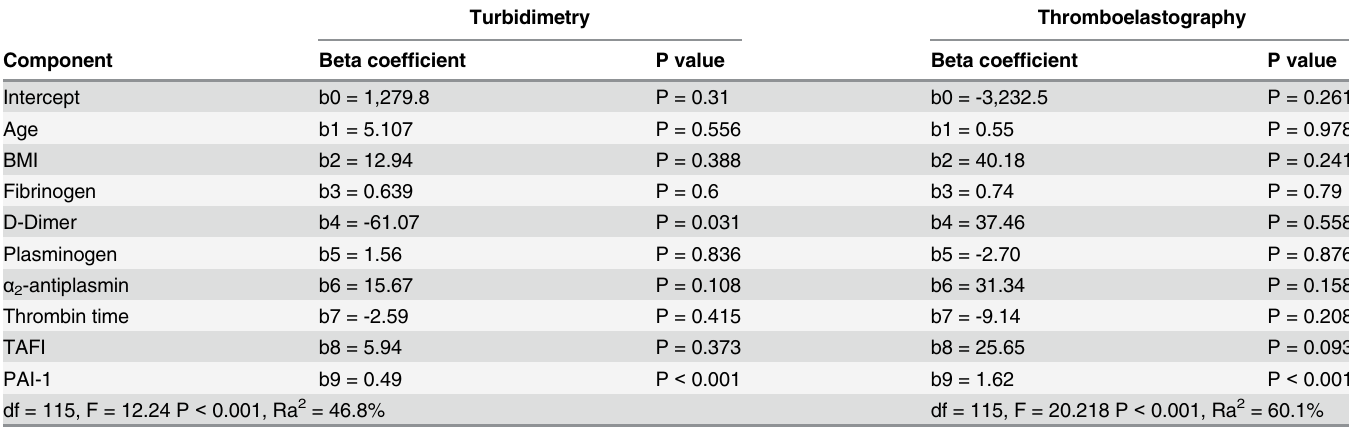
Table 4. β coefficients and P values for independent variables of multivariate linear regression *